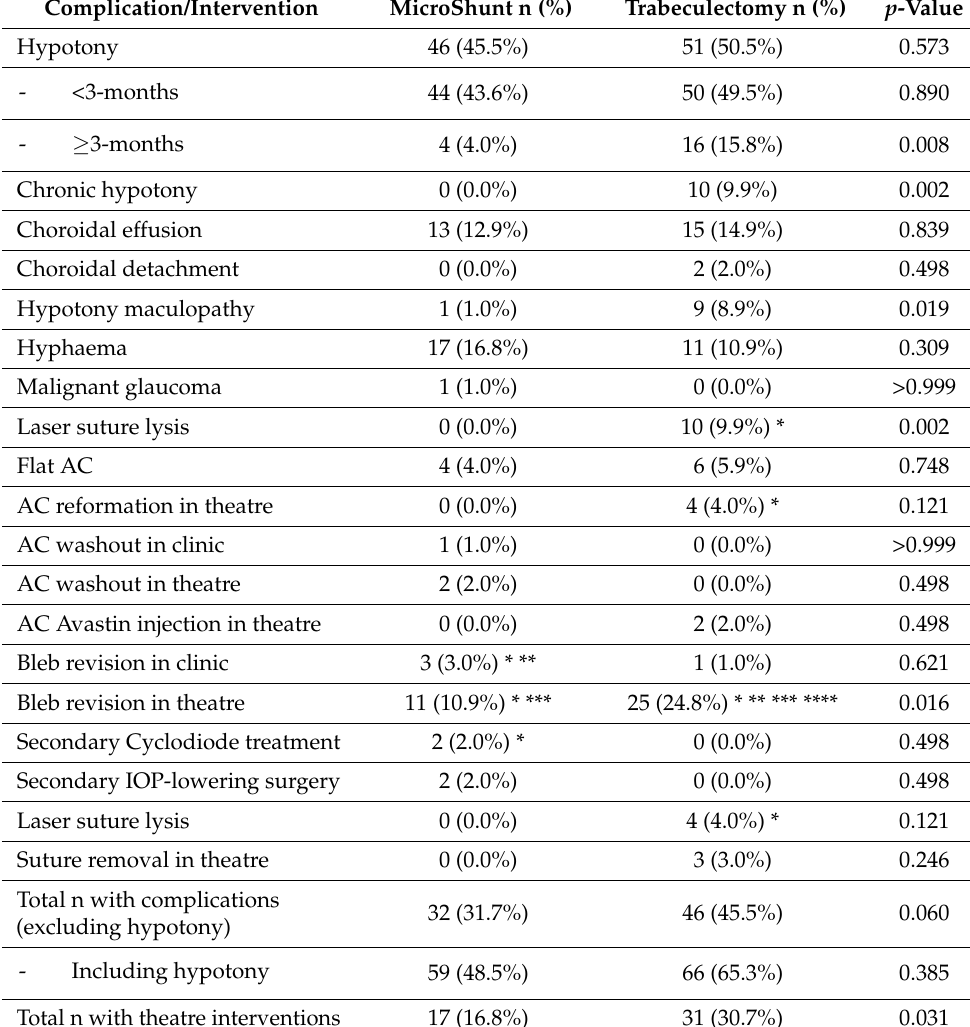
Table 3. Numbers and proportions of patients with complications and interventions in both groups (* includes a patient with two occurrences, ** includes one patient with three occurrences, *** includes two patients with two occurrences, **** includes one patient with 5